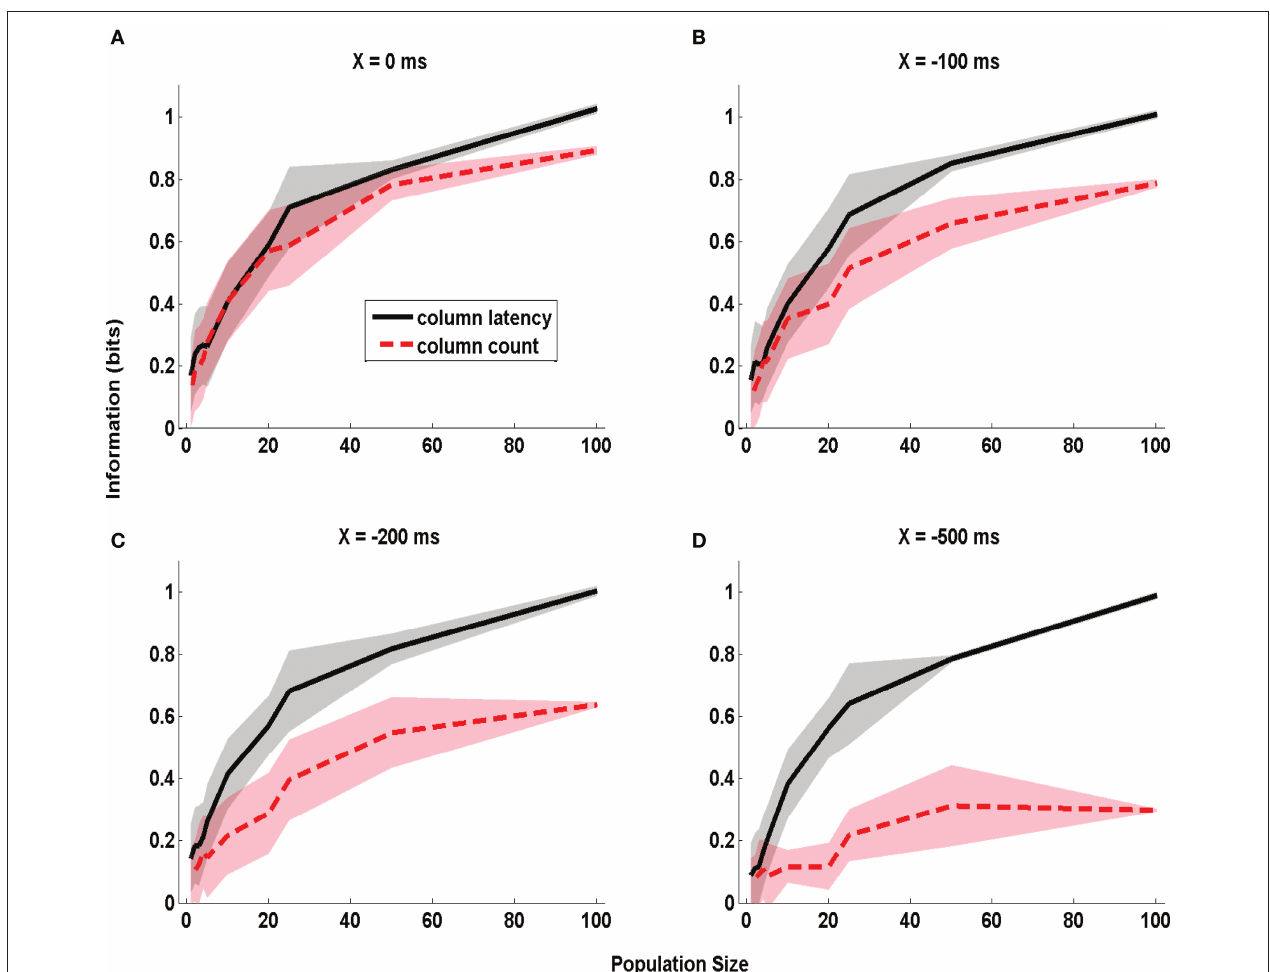
to 50 ms post-stimulus, and is plotted as a function of the size of the population of D2 neurons considered. (A–D) Report information values which were obtained when using respectively the values 0, − 100, − 200, and − 500 ms for the parameter X quantifying the uncertainty about the stimulus time. Results are plotted as average ( ± SD; colored area) across all analyzed subgroups of cells with the specified population